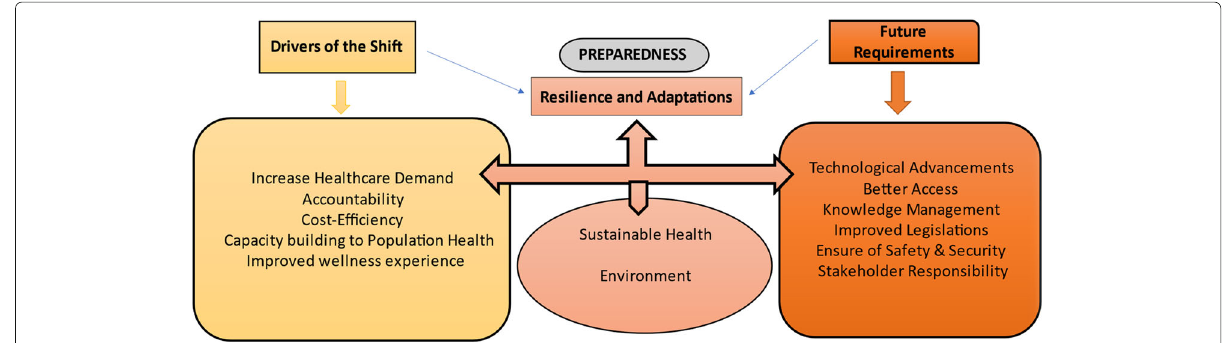
Fig. 2 Coherent Strategy to implement Telehealth